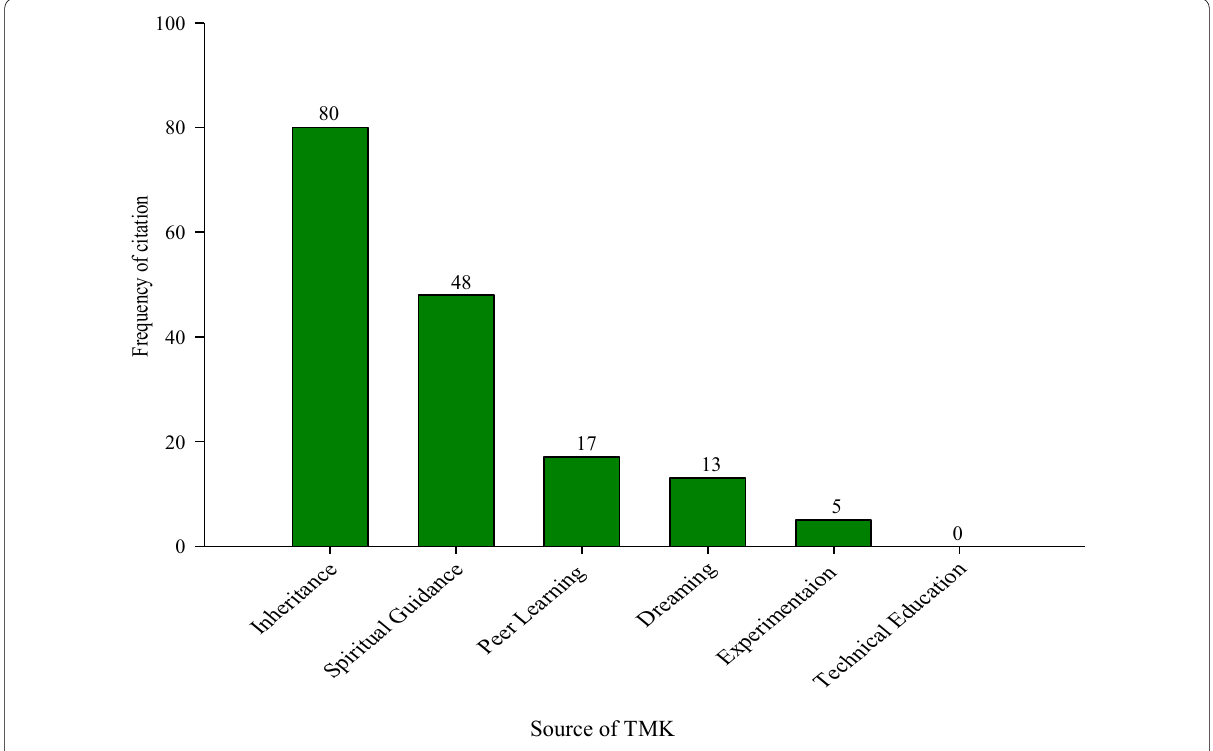
Fig. 2 Sources of TMK among traditional medical practitioners in selected rural villages in Butaleja District, Eastern